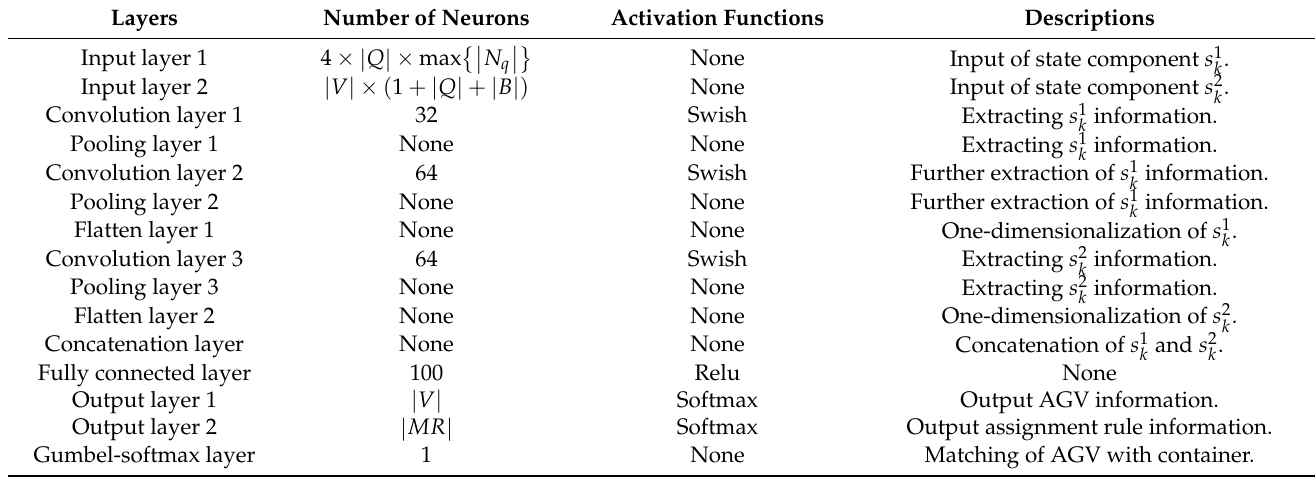
Table 4. Details of the Actor network structure.